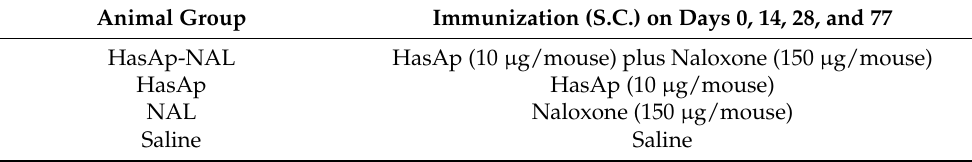
Table 1. Summary of the used animal immunization protocol. Animal